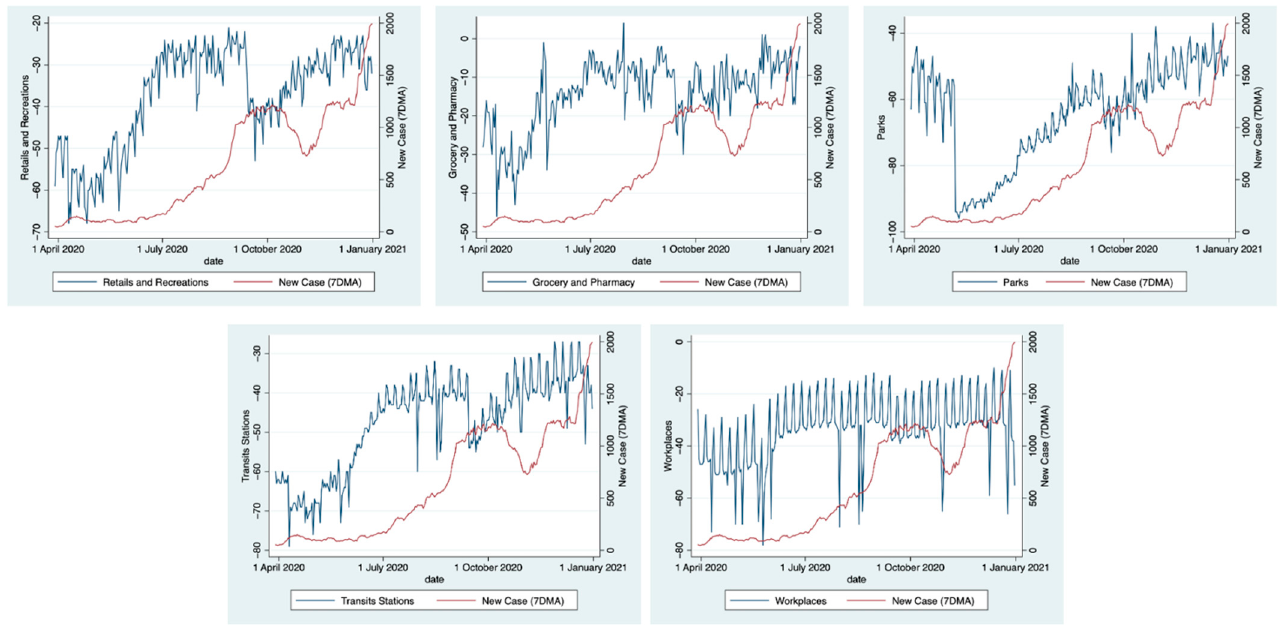
Figure 3. Changes in human mobility in Jakarta, 2020.